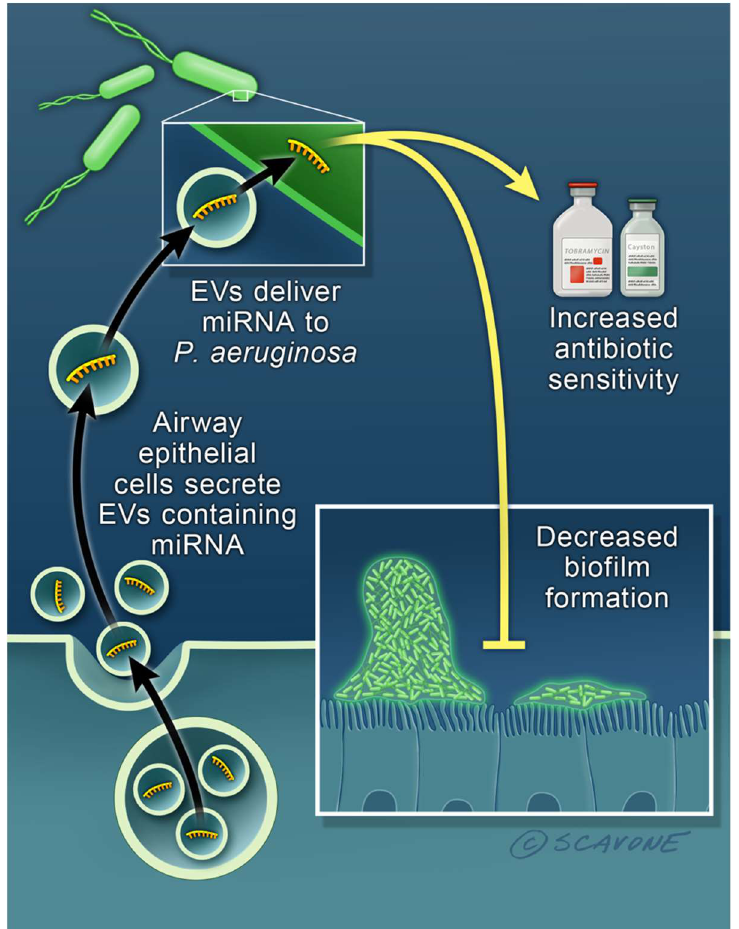
Figure 2. EVs (extracellular vesicles) secreted by mammalian (human) lung epithelial cells contain a miRNA that increase the sensitivity of P. aeruginosa to antibiotics and reduces biofilm formation. Airway epithelial cells secrete EVs which deliver the miRNA let-7b-5p to P. aeruginosa. Let-7b-5p reduces the formation of antibiotic resistant P. aeruginosa biofilms and increases the ability of anti- biotics to kill P. aeruginosa . A proteomic analysis of P. aeruginosa revealed that let-7b-5p increases the ability of β-lactam antibiotics to reduce biofilm formation by decreasing the abundance of